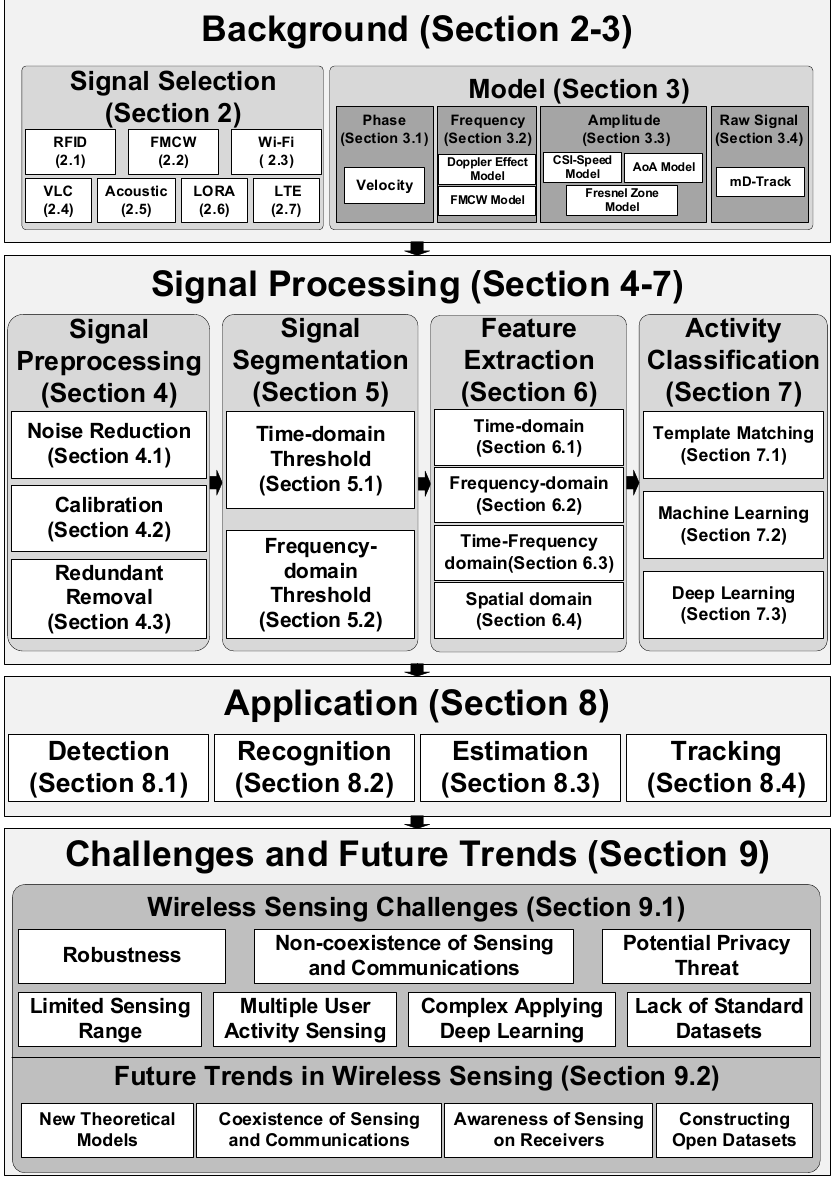
Figure 1. Overview of wireless sensing and survey organization.